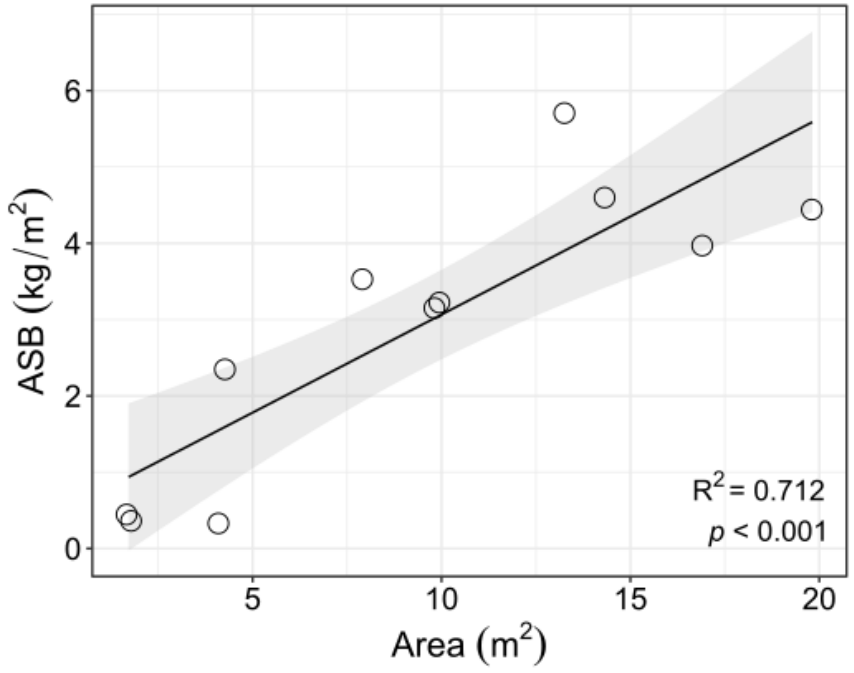
Figure 5. Area-specific biomass of drift algae in ice pits as a function of the ice pit area. Circle-like symbols representing the area-specific biomass of each sampled ice pit. The shaded ribbon spans the 95% confidence interval.